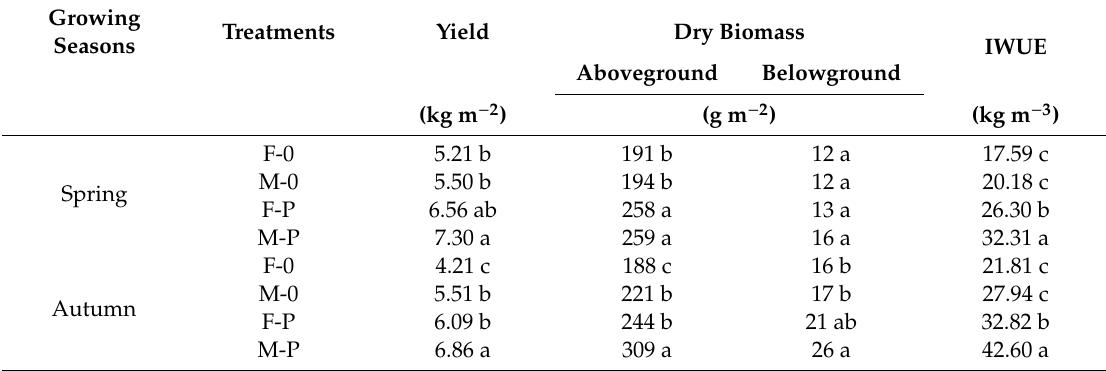
Table 1. The e ff ects of water management techniques on pakchoi yield, dry biomass accumulation, and irrigation water use e ffi ciency (IWUE) in spring and autumn seasons.